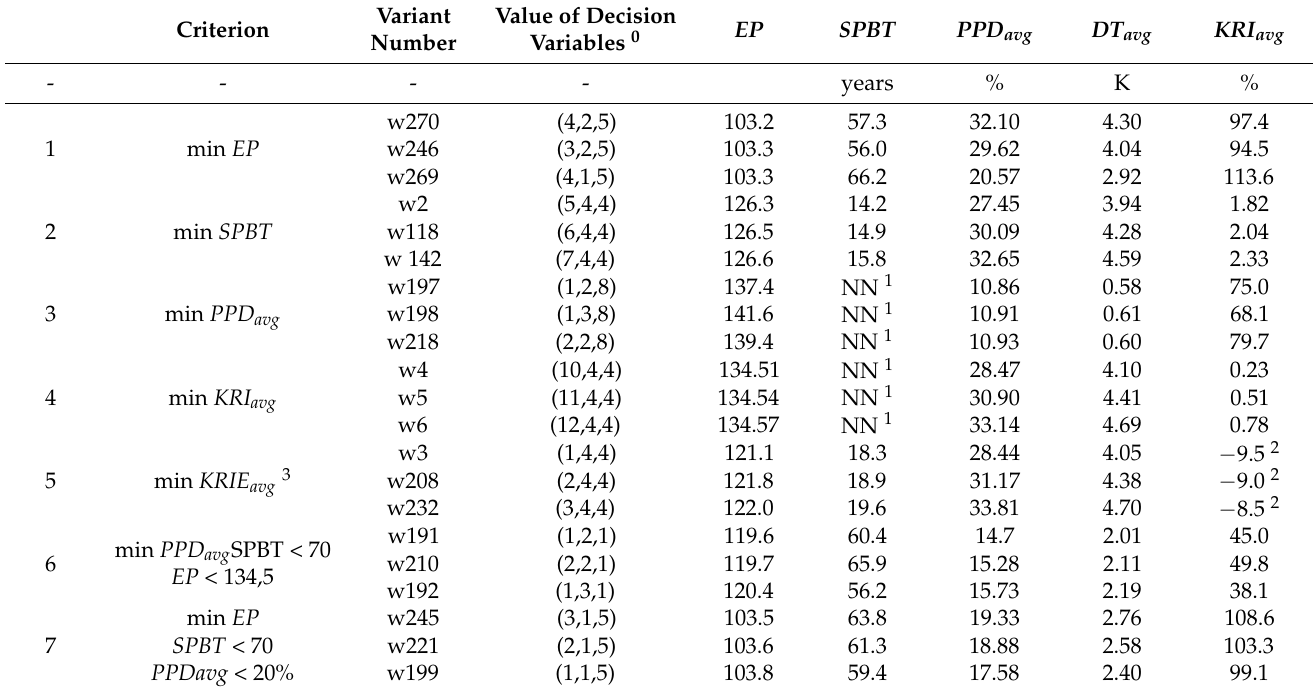
Table 15. Three best modernization solutions according to each